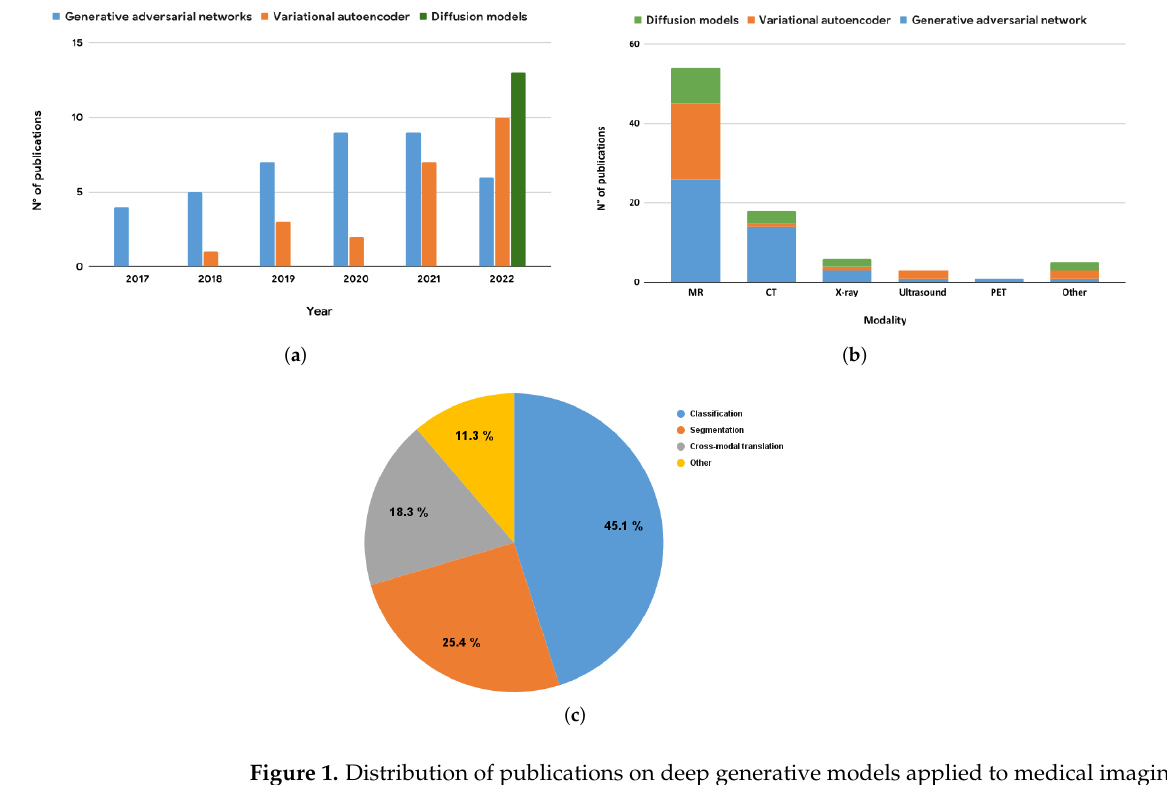
Figure 1. Distribution of publications on deep generative models applied to medical imaging data augmentation as of 2022. ( a ) The number of publications per architecture type and year. ( b ) The distribution of publications by modality, with CT and MRI being the most-commonly studied imaging modalities. Note that for cross-modal translation tasks, both the source and target modalities are counted in this plot. ( c ) The distribution of publications by downstream task, with segmentation and classification being the most common tasks in medical imaging. This figure illustrates the increasing interest in using deep generative models for data augmentation in medical imaging and highlights the diversity of tasks and modalities that have been addressed in the